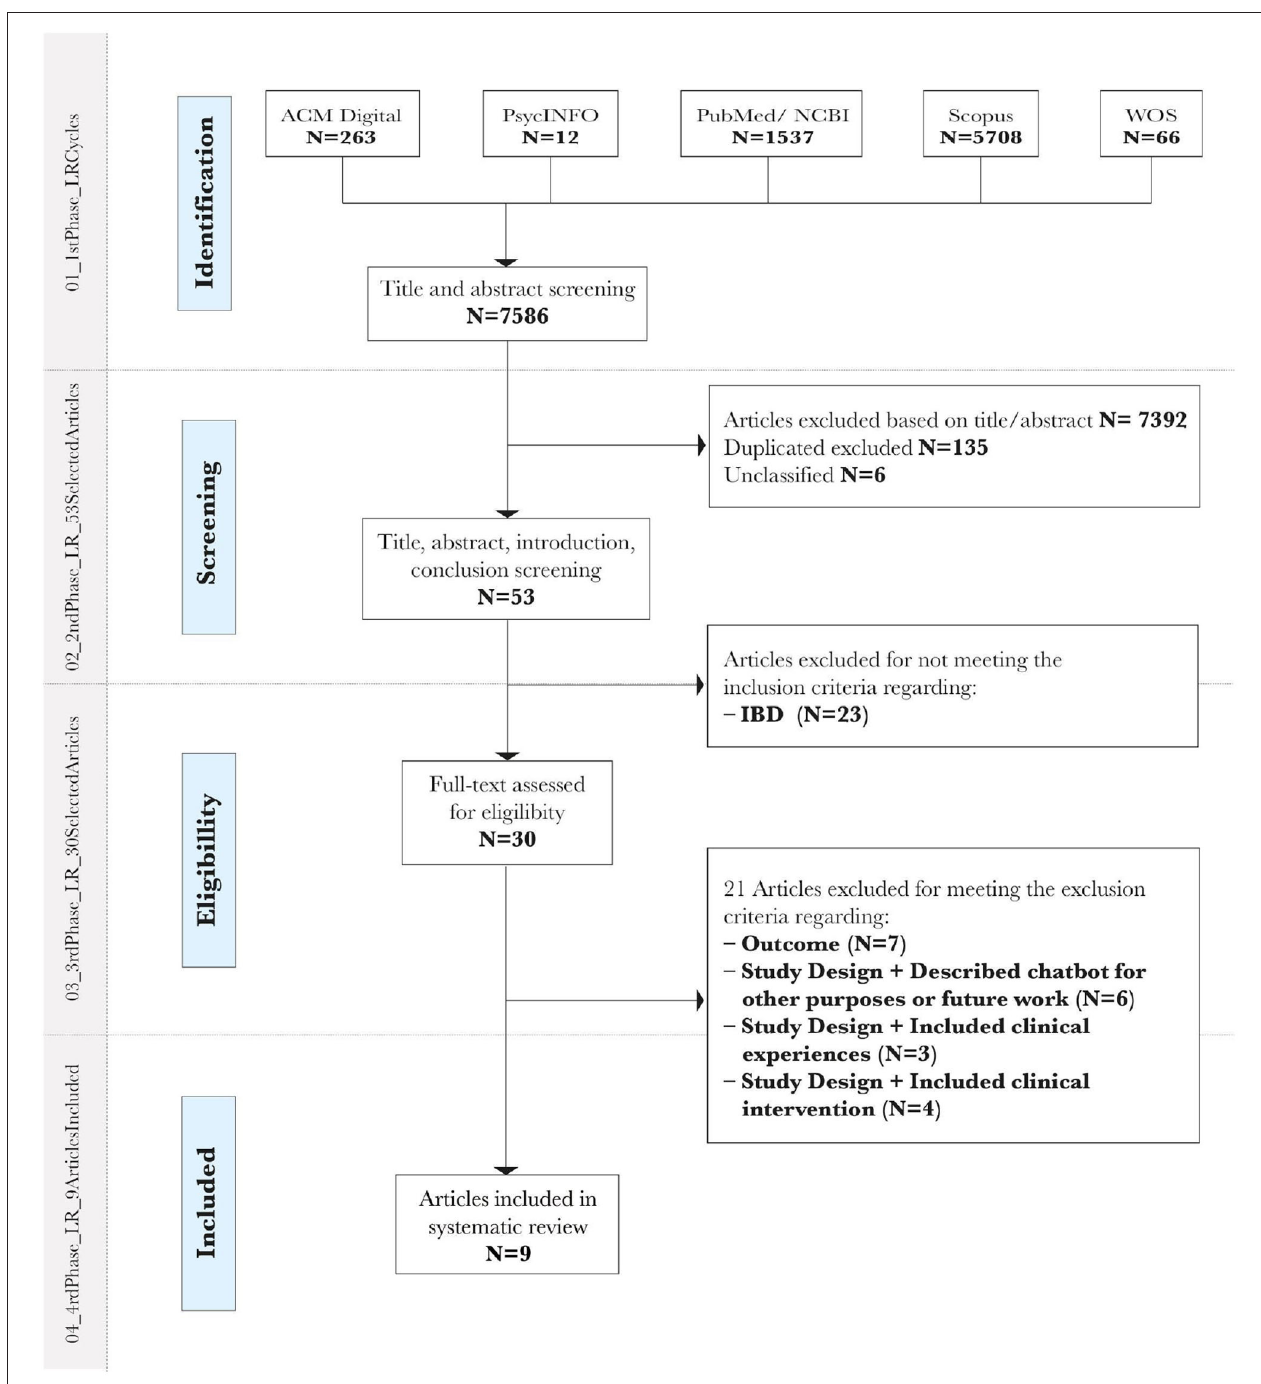
FIGURE 1 | PRISMA flow diagram for systematic